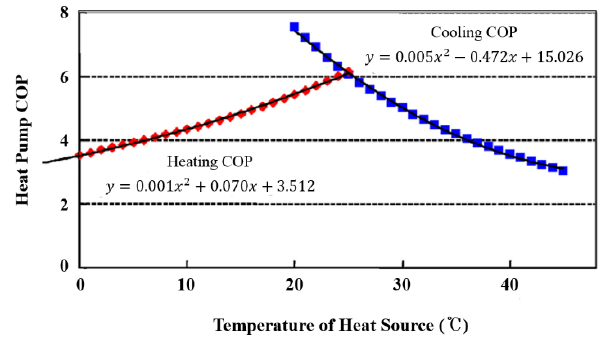
Figure 15. Heat pump COP [27].